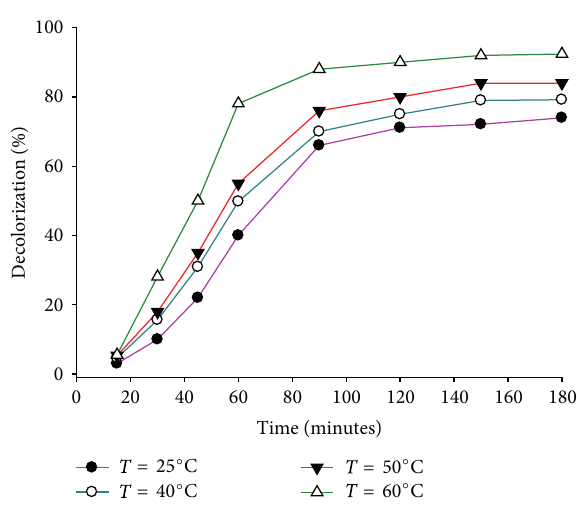
F 8: Effect of the reaction temperature on decolorization of catalyst; initial dye concentration, 20ppm; efficiency; 0.6gL initial solution pH; 55WHg lamp; continuous stirring; irradiation −1 time, 180min; room temperature.